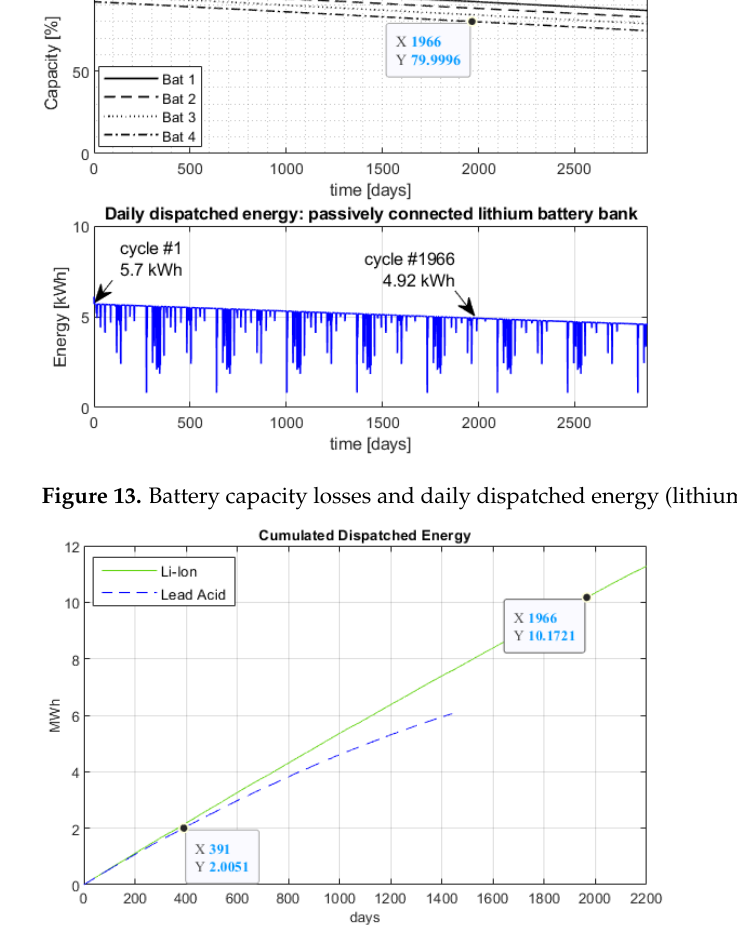
Figure 14. Cumulative dispatched energy (Lead-Acid and Li-Ion